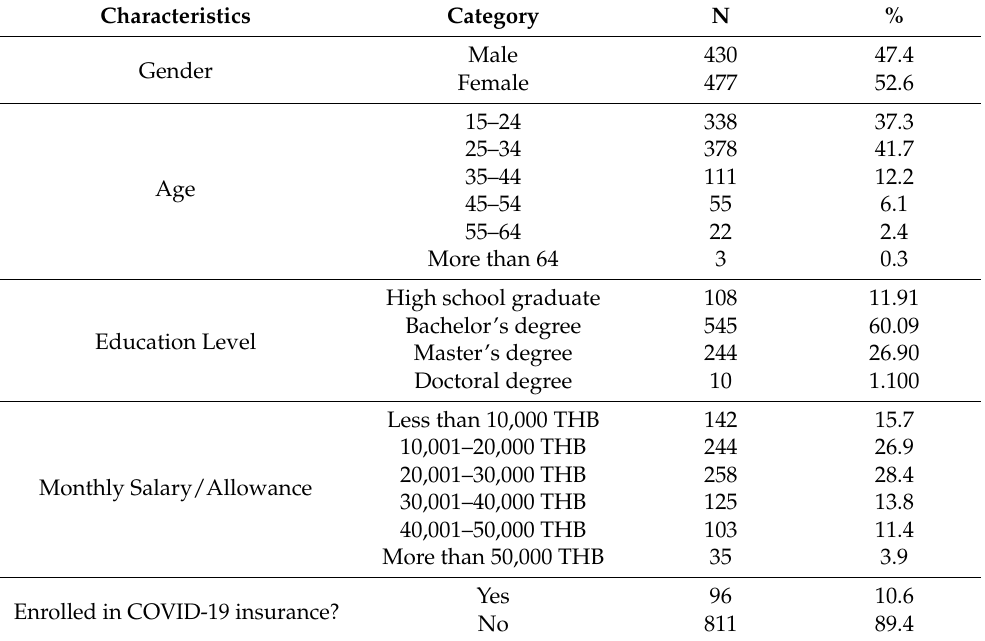
Table 1. Descriptive variables of survey (n =